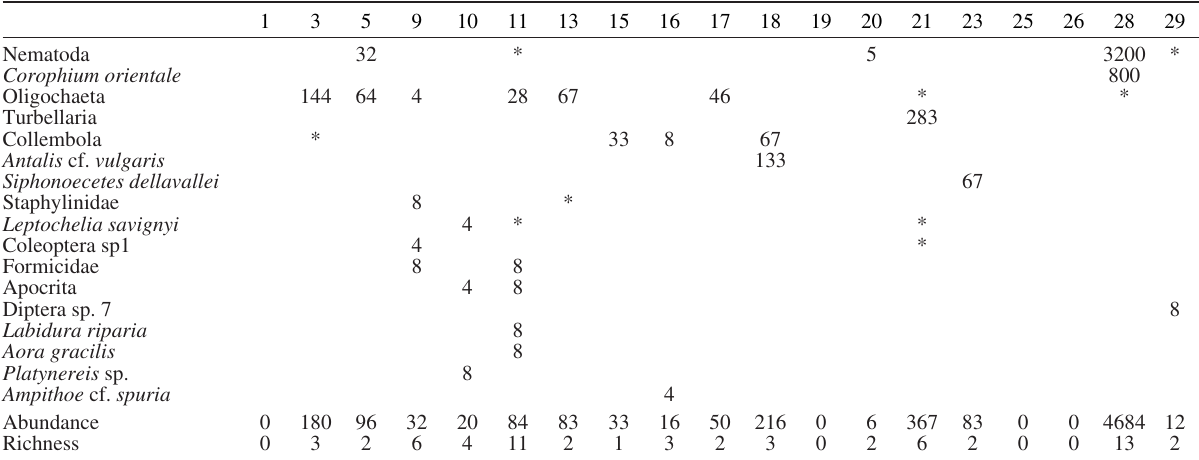
Table 4. – Main taxa collected at the supralittoral level with the grab method. Taxa are ordered by their total abundance (ind m –2 ). Only taxa representing up to 70% of the total abundance at each site are included. See Tables 1 and 2 for site numbers. Asterisks indicate widespread taxa that are not included in the 70% of the total abundance at a particular